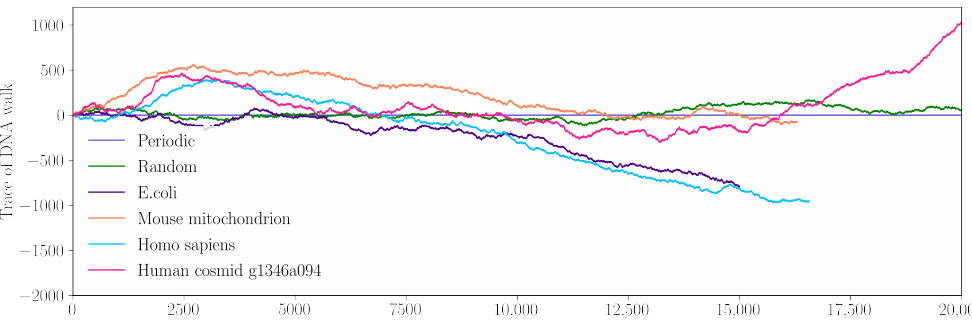
Figure 3. Time series representation of various sequences, as described in Section 2.3. (Light violet) Test sequence “ATGC” repeated 5 × 10 3 times. (Green) Test sequence consisting of 10 6 nucleotides randomly distributed, and chosen in such a way that their frequencies of occurrence are approximately equal. (Dark violet) E. coli , O145:H28 162405, sequence 161, GenBank ID: BJSS01000161 (15,000 bp). (Orange) M. mitochondrion, complete genome, GenBank ID: 342520 (16,295 bp). (Light blue) H. sapiens mitochondrion, complete genome NCBI Reference Sequence: NC_012920.1 (16,569 bp). (Pink) H. cosmid g1346a094, GenBank ID: AC000362.1 (40,977 bp).